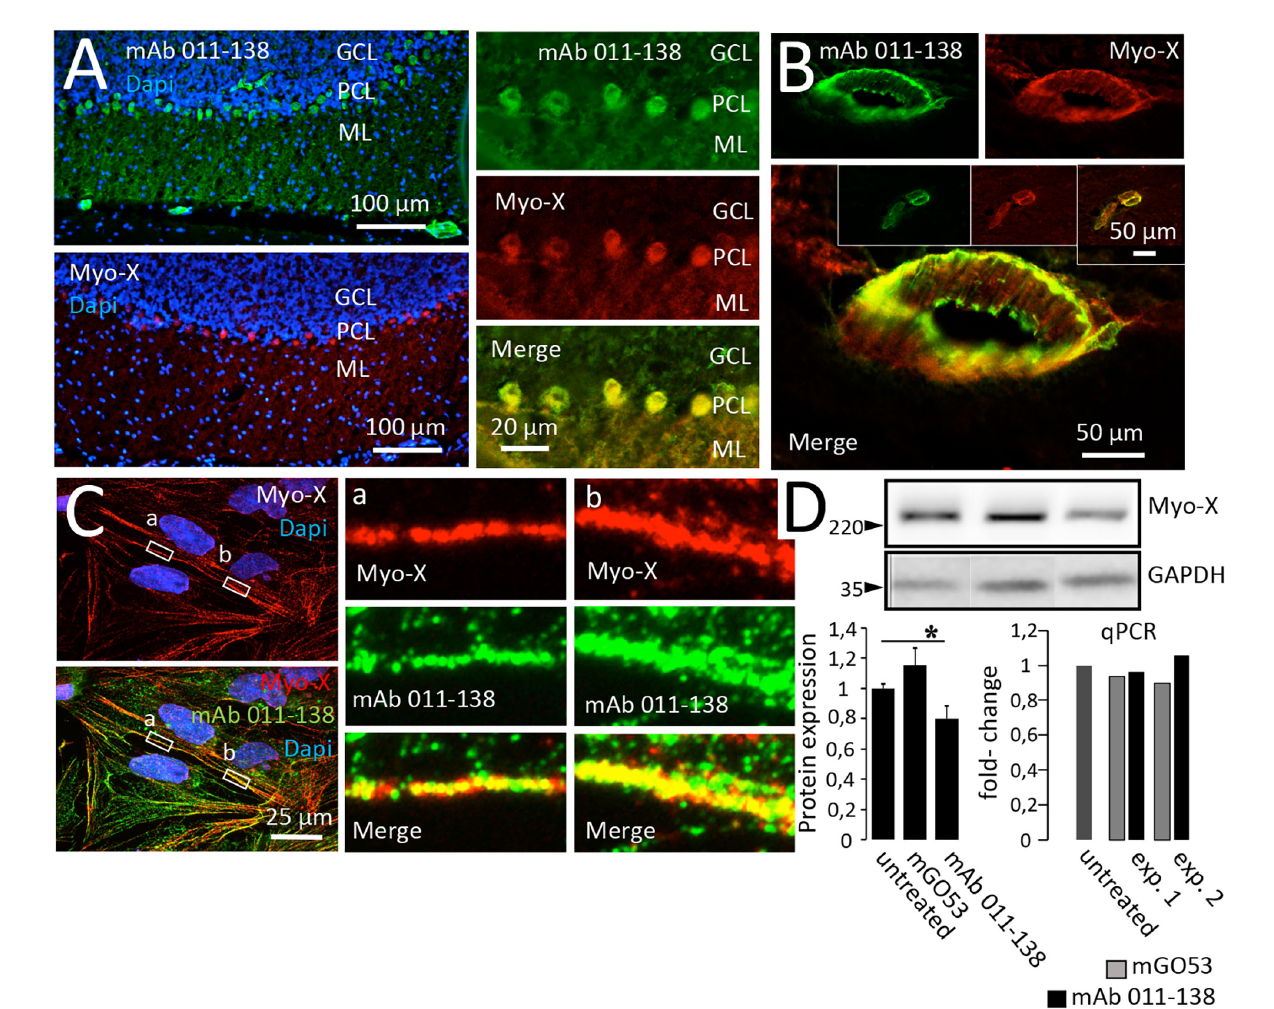
FIGURE6 Antibody 011-138 colocalizes with commercial anti-Myosin-X antibodies in brain sections and hCMEC/D3 cells and downregulates Myosin-X. (A) Unfixed and unpermeabilized sections from adult mouse brains were incubated with 5 µ g/ml of human monoclonal antibody (mAb) 011-138 and a commercial monoclonal mouse antibody directed against unconventional Myosin-X (Myo-X). Shown is the 3-layer cerebellar cortex consisting of the granule cell layer (GCL), Purkinje cell layer (PCL), and outermost molecular layer (ML). Incubation with mAb 011-138 resulted in staining of the Purkinje cell somata and larger blood vessels (upper panel). Staining with commercial anti-Myo-X antibody showed a comparable pattern (lower panel, no larger vessels present). Double staining revealed a high degree of signal overlap between patient 011-138 and commercial MyoX antibodies in Purkinje cells. (B) Likewise, double staining revealed a high degree of signal overlap between patient 011-138 and commercial Myo-X antibodies in mid-size (insets) to larger blood vessels. (C) Double incubation of fixed hCMEC/D3 cells with antibody 011-138 and commercial anti-Myosin-X IgG. Both stainings yielded a similar staining pattern with partially overlapping signals (see insets). (D) Incubation of hCMEC/D3 cells with mAb 011-38 results in the downregulation of Myo-X. Following incubation of hCMEC/D3 cells with 5 µ g/ml of mAb 011-138 or mGO53 as control for 48 h cells were homogenized and subjected to Western blotting and quantitative PCR to check for protein expression and gene regulation. Incubation with mAb 011-138 decreased protein expression of Myo-X by 20% (left chart), gene regulation was unaltered (right chart). Data are given as normalized means ± SEM adjusted to loading from two individual experiments analyzed in duplicates (Western blot) and as two individual experiments (qPCR). * p ≤